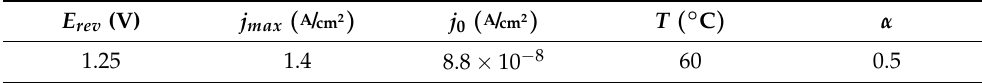
Table 1. Main parameters for the polarization curve